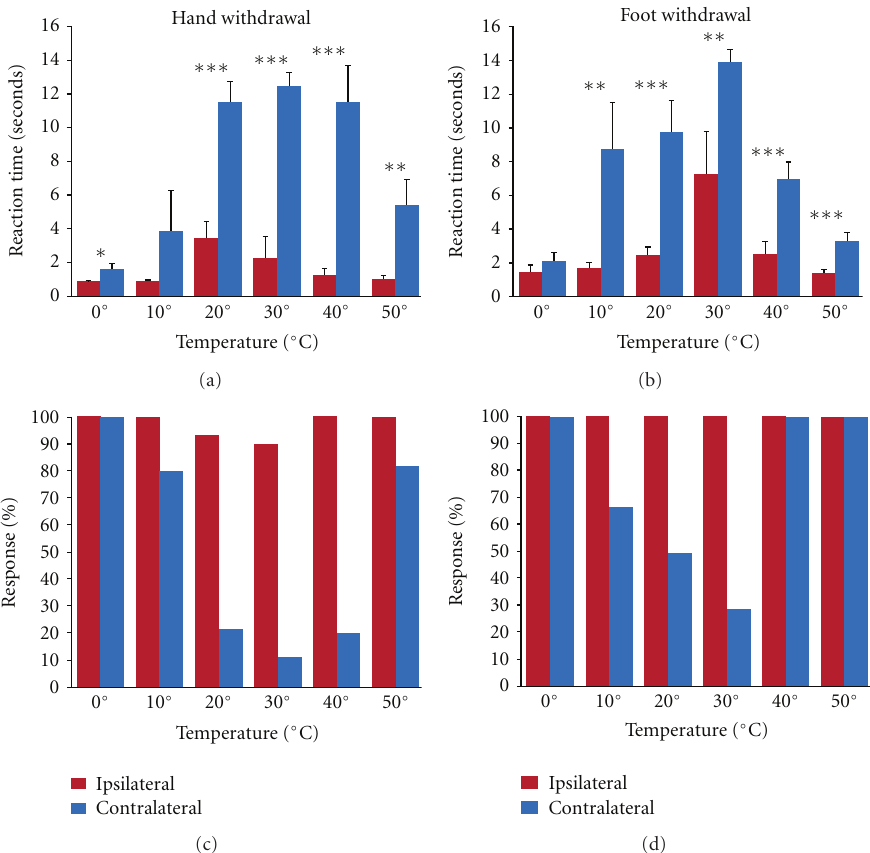
Figure 5: Thermal sensitivity: thermal sensitivity was tested in the infant-lesioned subjects at 3 years of age. The ipsilateral side of the body acts as a control for normal response to thermal stimuli and, as stated earlier, did not show any paretic movements. Withdrawal times were significantly longer for the contralateral (paretic side) than for the ipsilateral (nonparetic) limb (a and b). The contralateral lower limb tended to have higher response rates than upper limb to thermal sensitivity (c and d). Withdrawal response rates did not di ff er between upper and lower ipsilateral limbs. ∗ P < 0 . 05, ∗∗ P < 0 . 01, ∗∗∗ P < 0 .